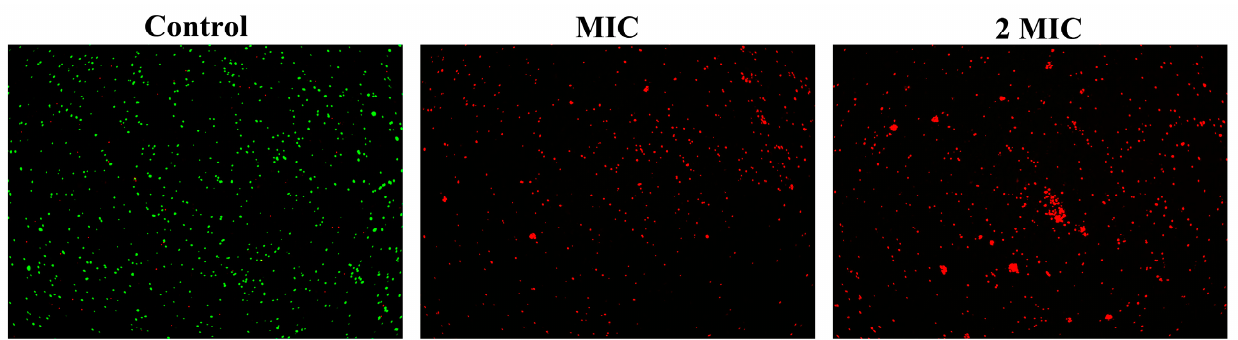
Figure 3. Laser confocal observation of the effect of juglone on the membrane integrity of S. aureus . The PI dye label shows red fluorescence and the SYTO 9 dye label shows green fluorescence. The magnification was 200×.